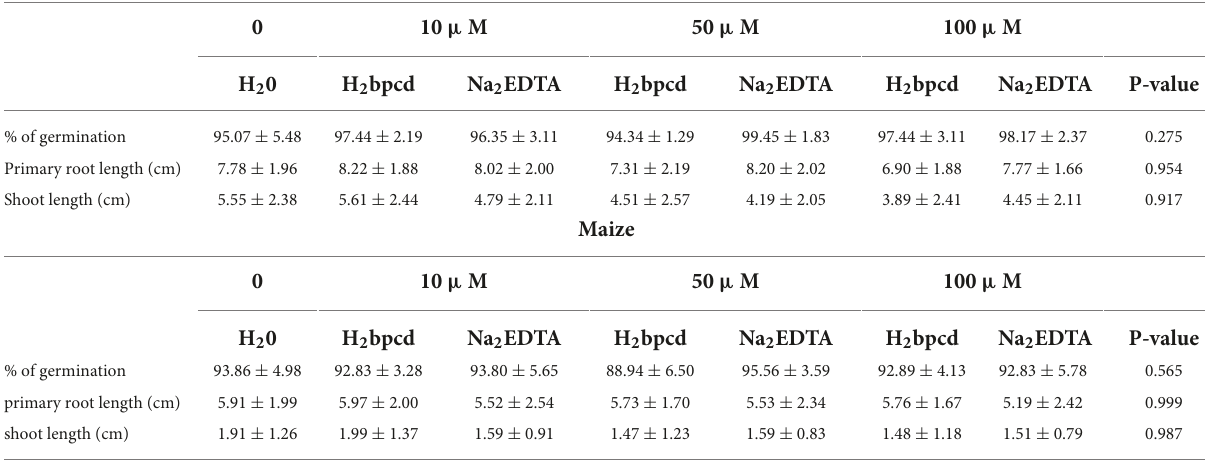
TABLE 2 Comparison of germination parameters for cucumber and maize seedlings when treated with different doses (10, 50, and 100 µ M) of H 2 bpcd or Na 2 EDTA.